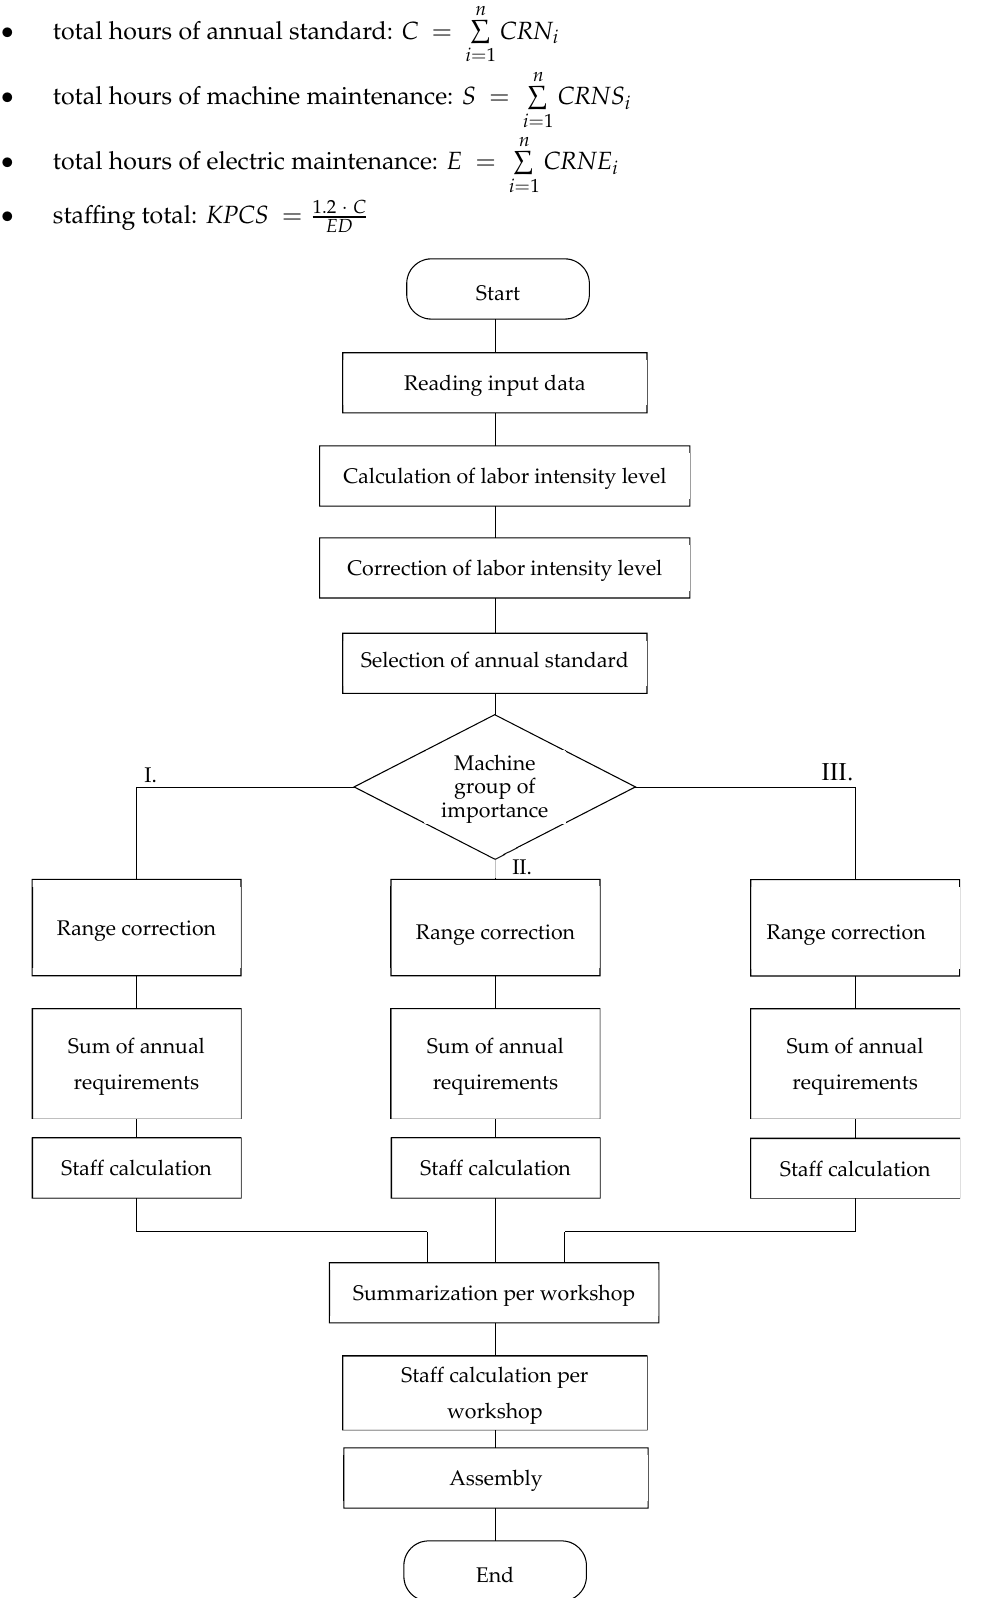
Figure 9. Flow chart of the program for standard assignment. Source: authors.